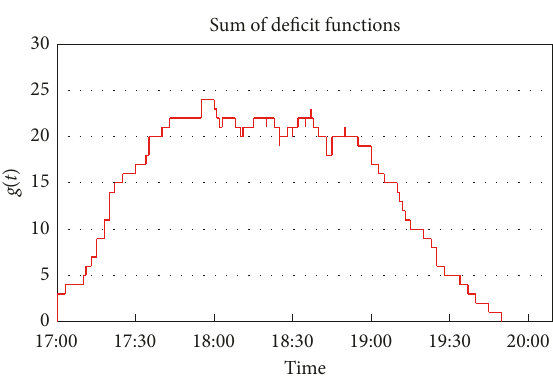
Figure 8: Sum of deficit functions after inserting DH and